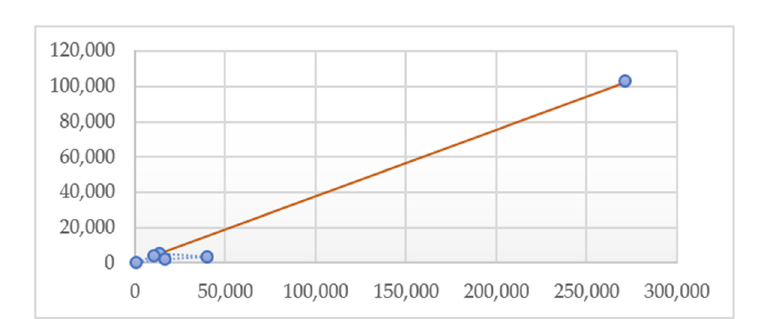
Figure A1. Regression line with the scatter plot.